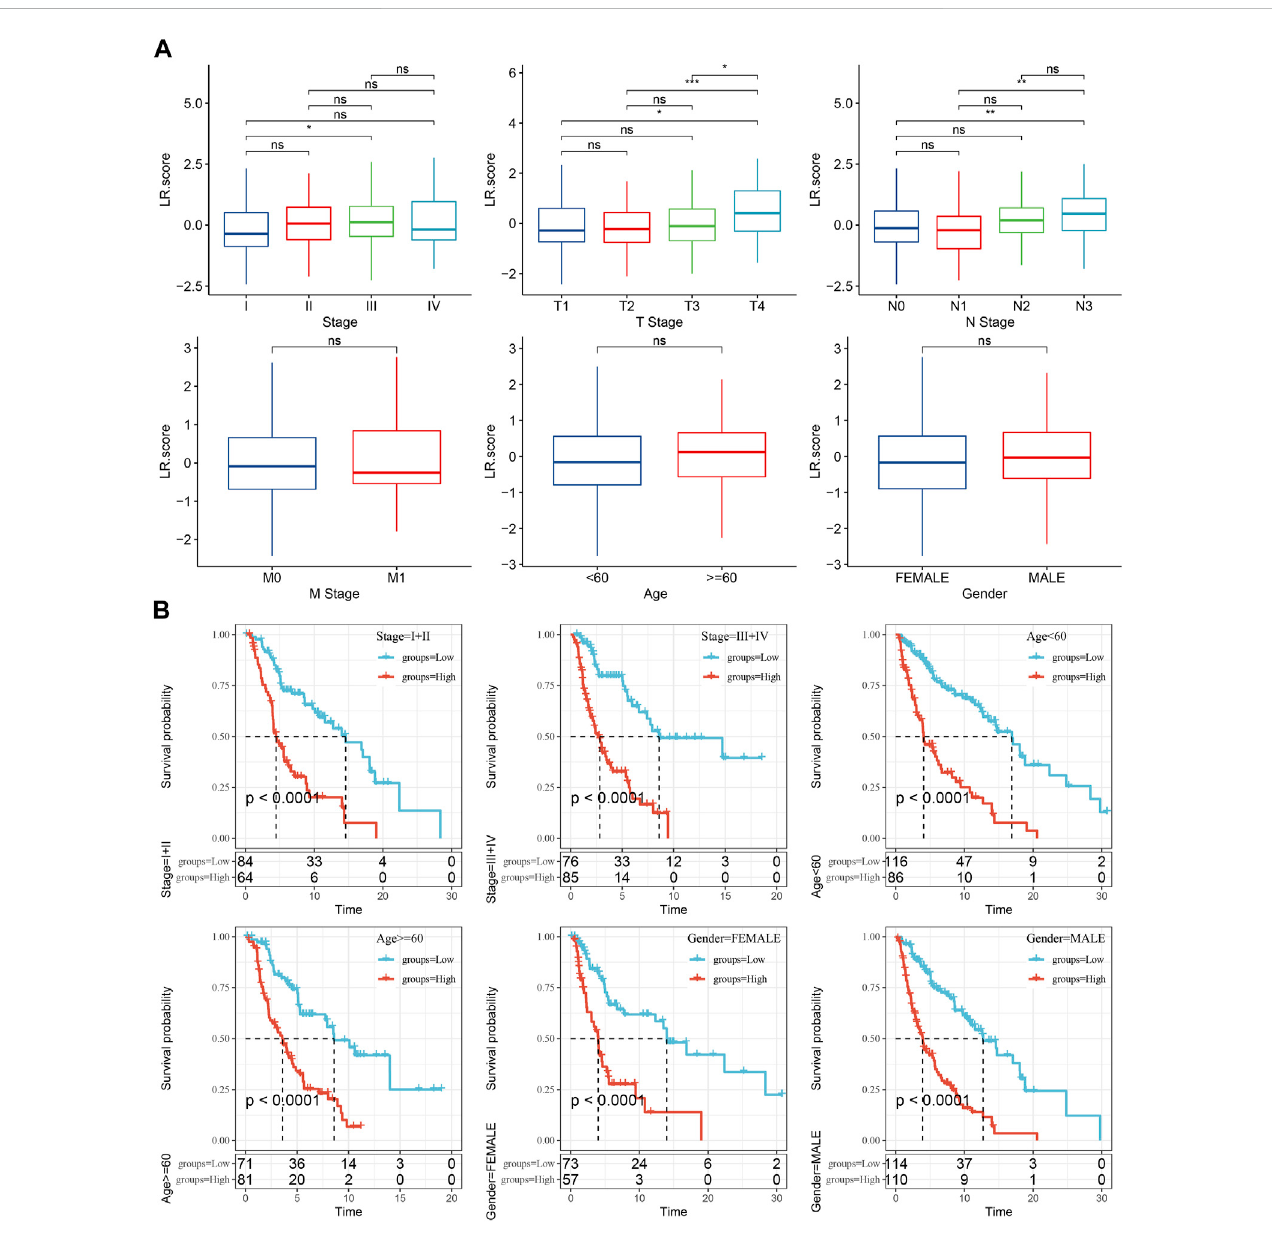
FIGURE 8 Clinical features of LR.score. (A) Distribution differences of LR.score in different clinicopathological features in TCGA-SKCM cohort. (B) KM curve between high and low risk groups of LR.score among different clinicopathological groups in TCGA-SKCM